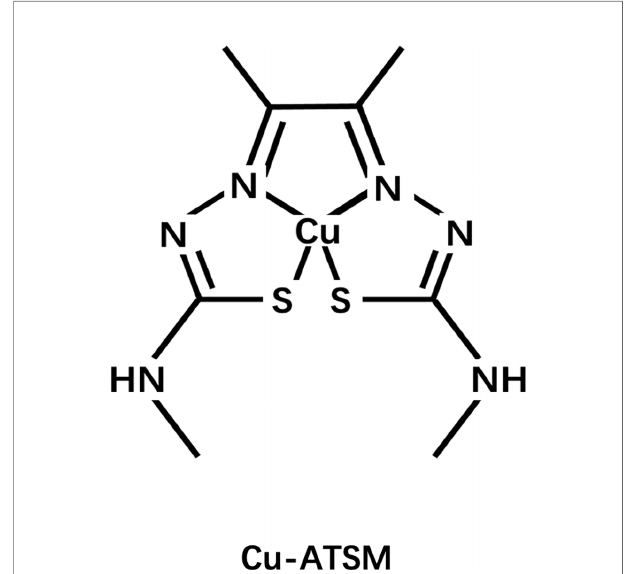
FIGURE 5 | Structure of